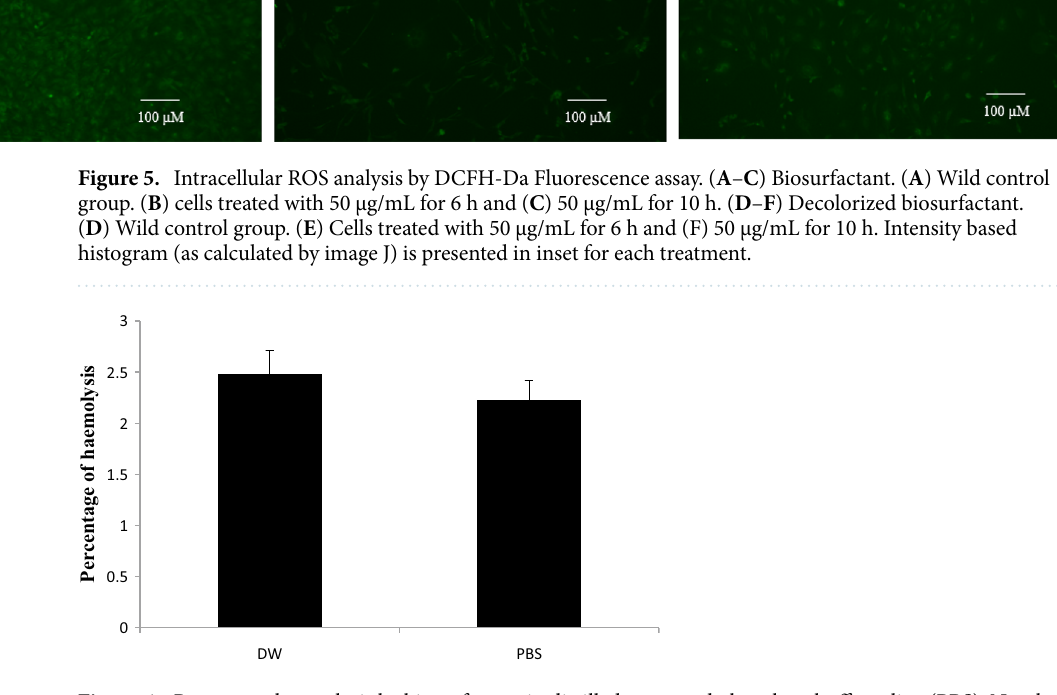
Figure 6. Percentage haemolysis by biosurfactant in distilled water and phosphate buffer saline (PBS). Number of observations: 6, Error bars in the graphs represents standard